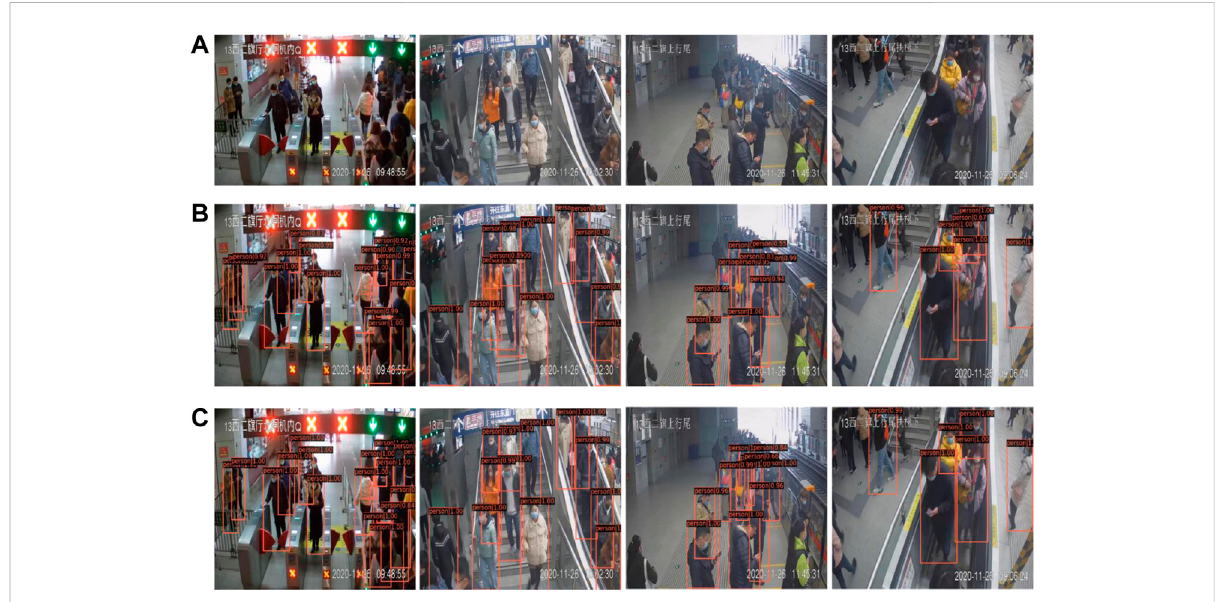
FIGURE 7 Comparison of practical application effects between RetinaNet and MPDNet. (A) The original images. (B) The results of RetinaNet. (C) The results of MPDNet.